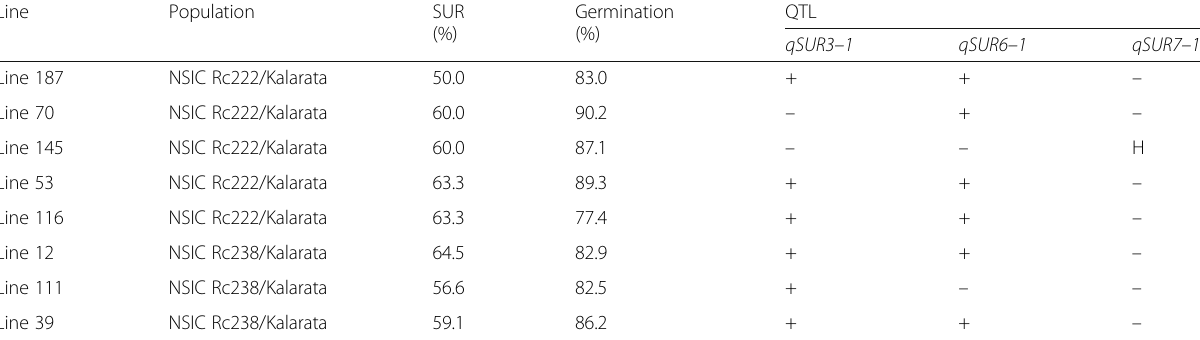
Table 5 Donor Lines With Varying Combinations of The Three QTLs (in heterozygote condition for qSUR7 – 1 ), white-colored pericarp, high survival under AG, and germination under control